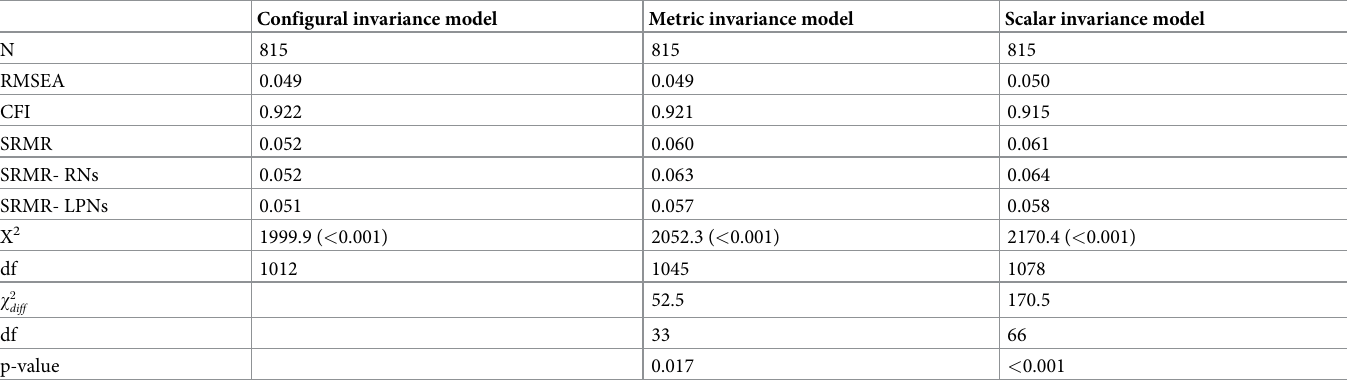
Table 5. Test of measurement invariance between RNs and LPNs for the seven scale-based concepts of the